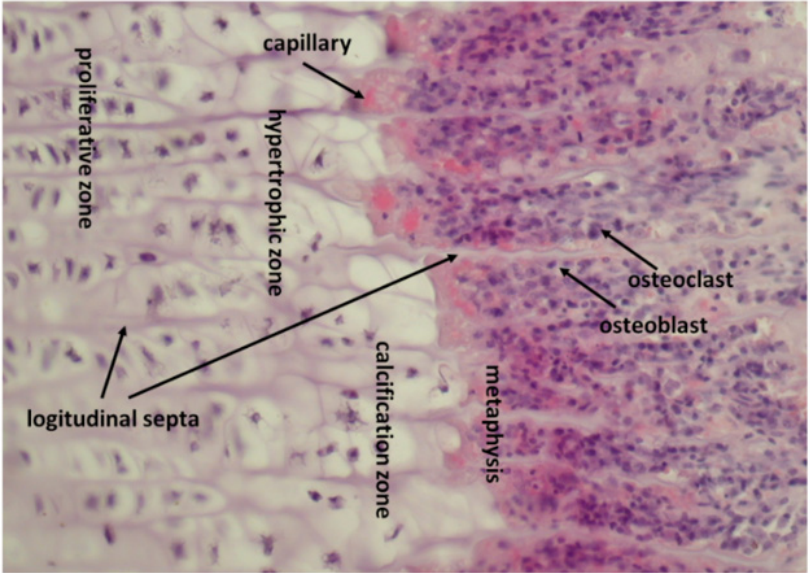
Figure 2. Structure of calf costochondral junction. Proliferative, hypertrophic and provisional calcification zones are present. The latter is connected with the metaphysis. Chondrocytes in the proliferative and hypertrophic zones form elongated columns separated by longitudinal septa formed by cartilage matrix. Chondrocytes within the columns are separated by transverse septa. In the zone of provisional calcification, longitudinal septa are calcified. Septoclasts occur around capillaries at the boundary of metaphysis and provisional calcification zone, but it is impossible to recognize them in haematoxylin and eosin staining. Septoclasts resorb the noncalcified transverse septa, whereas the calcified longitudinal septa are resorbed by osteoclasts. Osteoblasts deposit bone on the remnants of longitudinal septa. HE, magnification, x200.